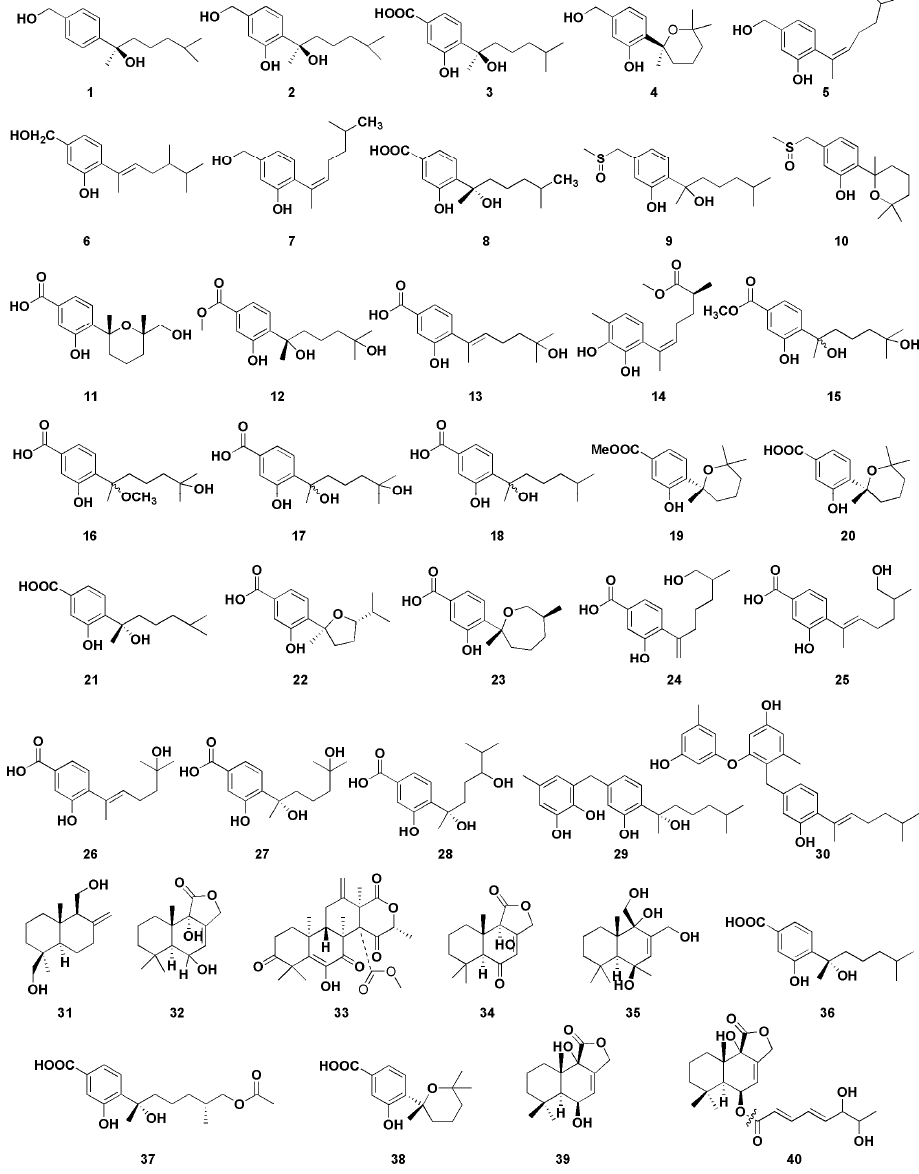
Figure 5. Chemical structures of antimicrobial compounds ( 1 – 40 ).